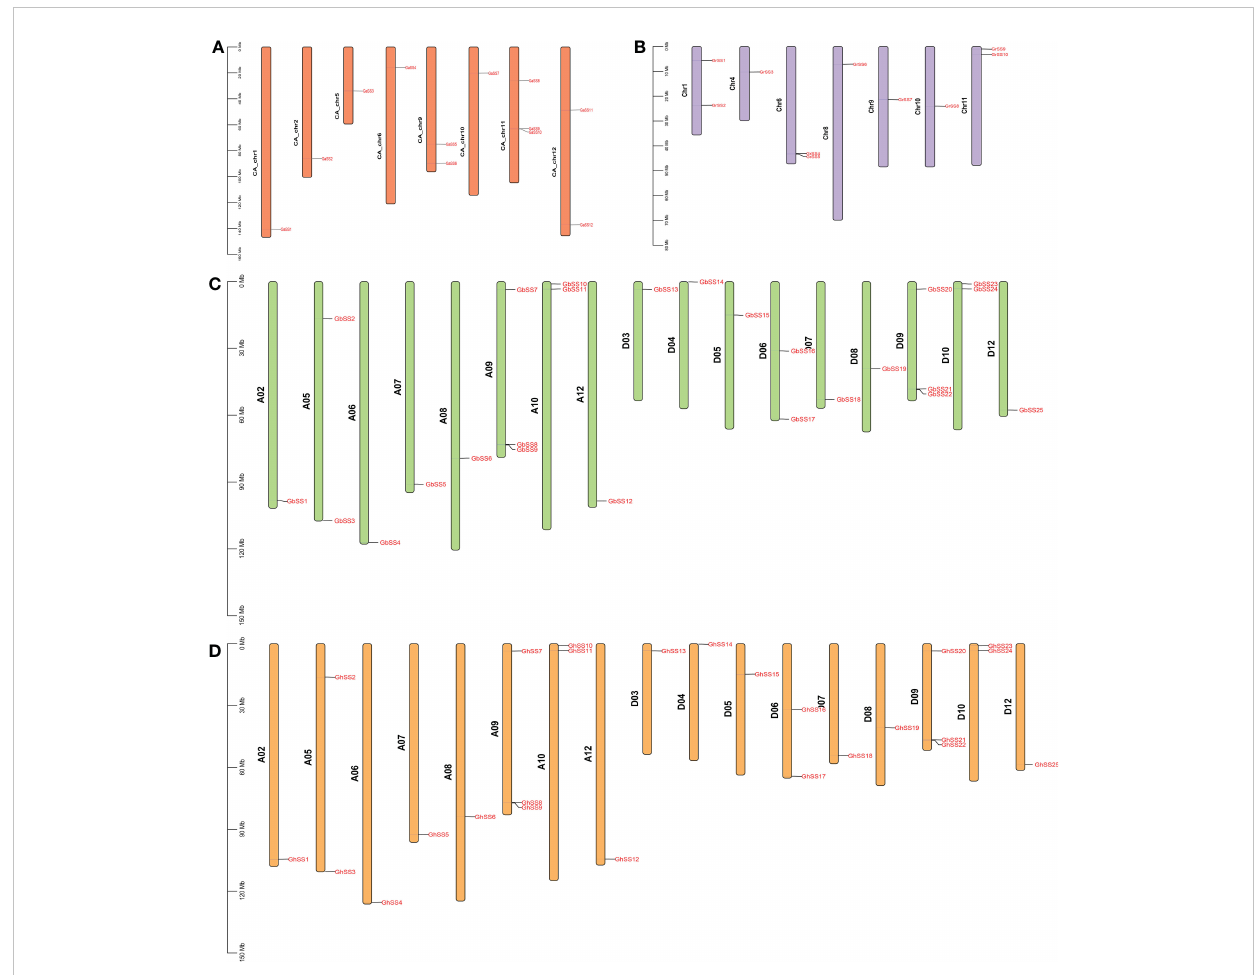
FIGURE 3 Chromosomal locations of SS genes in G arboreum, G raimondii, G hirsutum, and G barbadense. (A) G arboretum, (B) G raimondii, (C) G barbadense, and (D) G